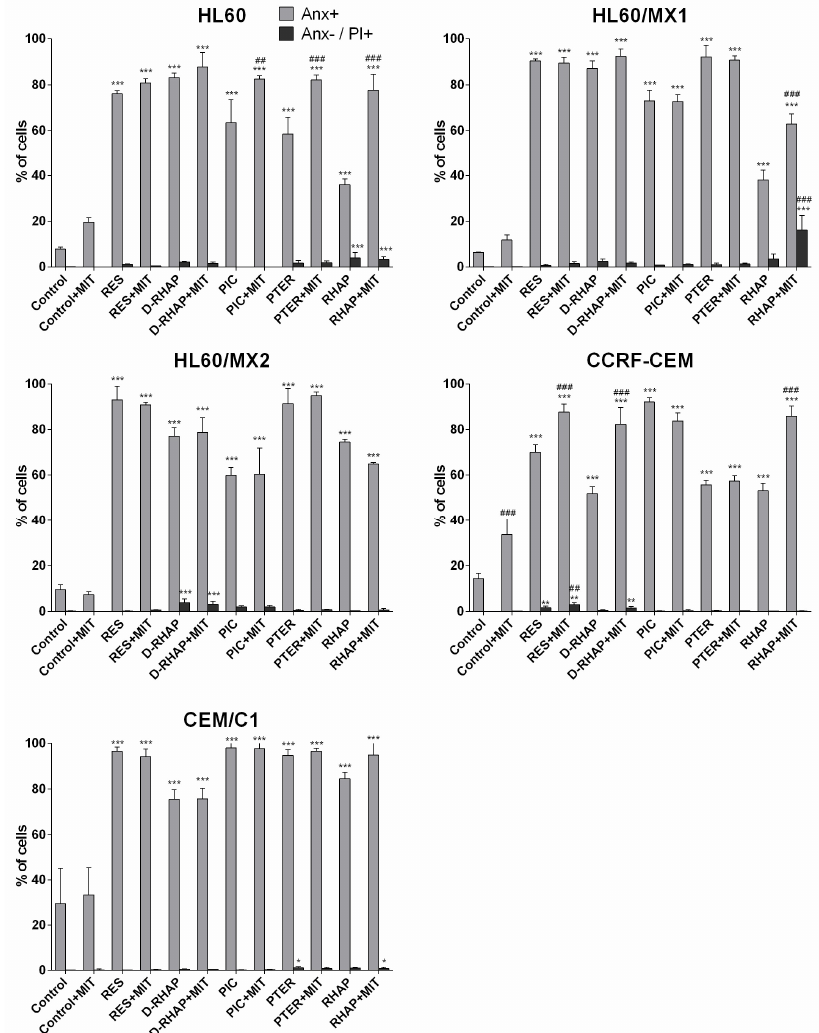
Figure 7. Apoptosis analysis using Annexin V and propidium iodide on cell lines induced with tested stilbene derivatives with absence and presence of mitoxantrone. Explanations: see Figure 6 ( n =